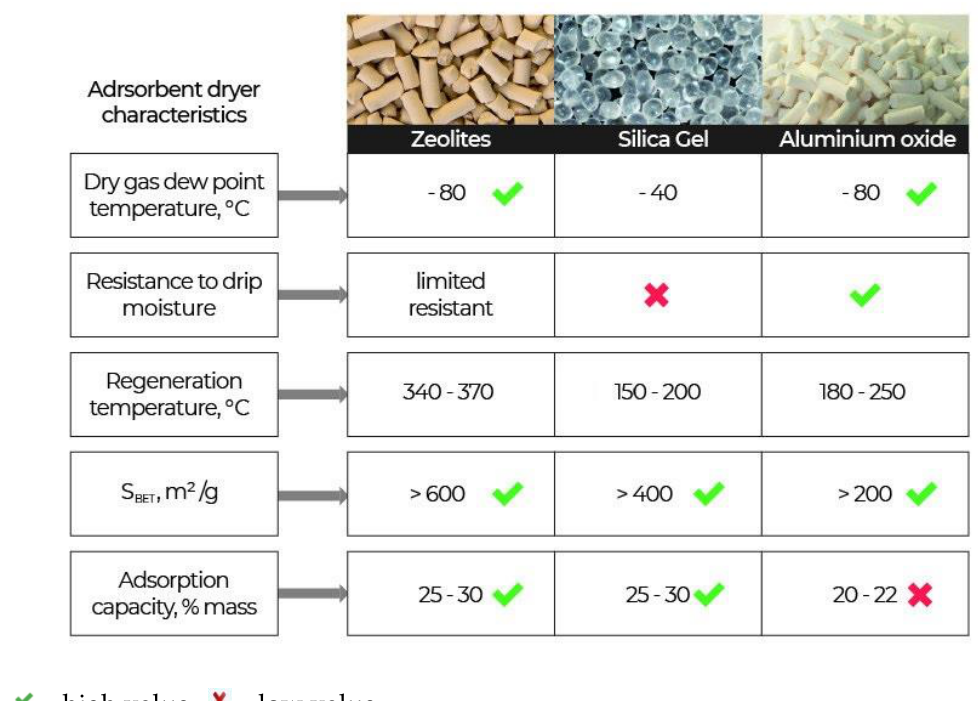
Figure 1. Characteristics of the basic adsorbents-desiccants. Zeolites have sufficiently large adsorption capacity by water, but they are costly and difficult to regenerate. Prolonged time and temperatures above 340 ◦ C are required for their regeneration. A distinctive feature of zeolites is a high adsorption rate of water vapour (steep rise of isotherms) in the area of low concentrations of water vapour. The amount of the absorbed water reaches a maximum value with a relative humidity equal to 20% and practically remains constant with a subsequent increase in the air humidity [14]. The second distinctive feature of adsorption of water vapour on zeolites is a weak dependence of its adsorption capacity on the temperature. At a temperature of 100 ◦ C and a pressure of 10 mm of mercury, the adsorption capacity of zeolites reaches 15 ÷ 16 g/100 g of the adsorbent. Even at 200 ◦ C, it is still significant at—3.6 g/100 g of the adsorbent [14]. The absorption capacity of silica gel depends on the temperature of humid air and partial pressure of vapour: When the temperature increases and the partial pressure of vapour decreases, this capacity decays. It is expedient to use silica gel, having a low regeneration temperature 150–200 ◦ C (see in Table 1 [5,14]), in desiccants of compressed air with hot regeneration at an adsorption temperature not higher than 35 ◦ C and content of water vapour in the dehumidified air not lower than 0.02 vol.%. The main disadvantage of silica gels is low water resistance [14], which leads to their destruction when in contact with water. The advantages of active aluminium oxide (AO), providing its wide application for gas dehydration, are high adsorption capacity as compared to zeolites with high relative humidity; thermal stability; a possibility of multiple regeneration, which determines its good indicators under operation conditions; water resistance, especially resistance to condensed moisture; and relative ease of production, as well as availability of raw